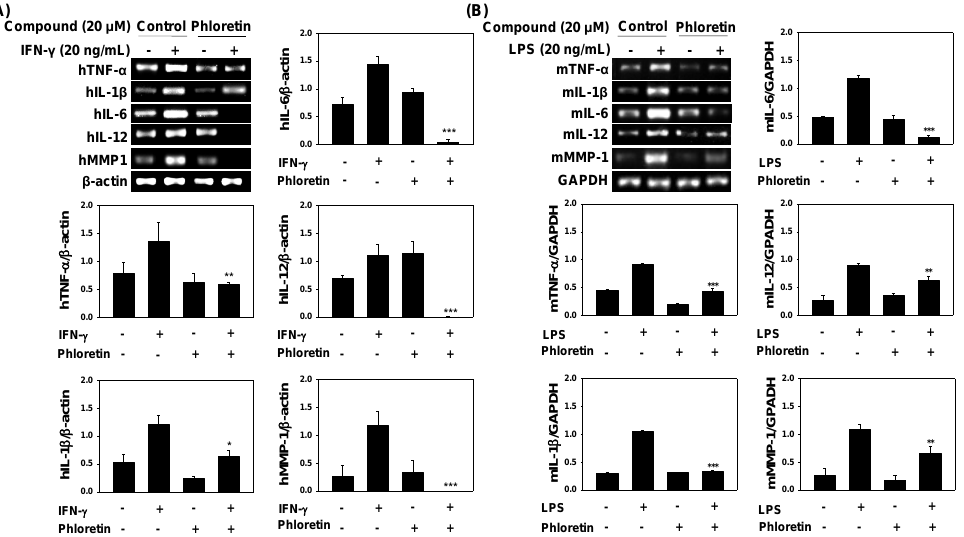
Figure 3. Effects of phloretin on mRNA expression of inflammatory cytokines ( A ) tumor necrosis factor (TNF)- α , interleukin (IL)-1 β , IL-6, IL-12, matrix metalloproteinase (MMP)-1, and β -actin in interferon (IFN)- γ -treated MRC-5 cells and their quantitative analysis of reverse transcription polymerase chain reaction results; and ( B ) TNF- α , IL-1 β , IL-6, IL-12, MMP-1, and Glyceraldehyde 3-phosphate dehydrogenase (GAPDH) in LPS-treated dendritic cells and their quantitative analysis of reverse transcription polymerase chain reaction results. Cells were untreated (negative control) or stimulated with 20 ng/mL IFN- γ for MRC-5 cells and 20 ng/mL LPS for dendritic cells in the presence or absence of phloretin for 3 h. Relative expression was quantified using ImageJ, and bars represent mean expression level ± standard deviation relative to β -actin for IFN- γ -treated MRC-5 cells and GAPDH for LPS-treated dendritic cells. * p < 0.05, ** p < 0.005, *** p < 0.001 vs. cells treated with IFN- γ or LPS only.